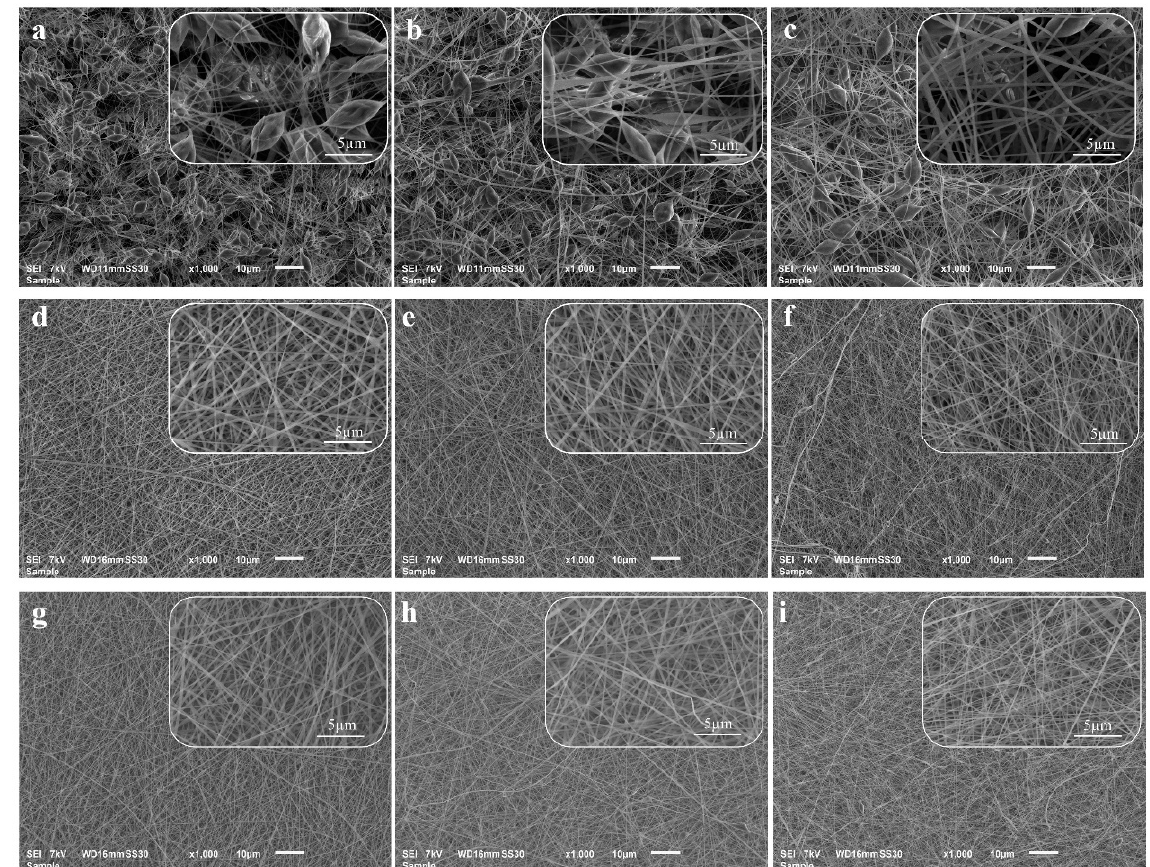
Figure 5. SEM images of ( a ) PLA, ( b ) PLA/PAni and ( c ) PLA/PAni:CSA nanofibers electrospun from their corresponding untreated solutions; ( d ) PLA, ( e ) PLA/PAni, ( f ) PLA/PAni:CSA nanofibers electrospun from their corresponding APPJ ‐ modified solutions; ( g ) PLA, ( h ) PLA/PAni, ( i ) PLA/PAni:CSA electrospun nanofibers after APPJ/DBD treatments (DBD exposure time: 15 s—Scale bar: large images 10 μ m and inset images 5 μ m).